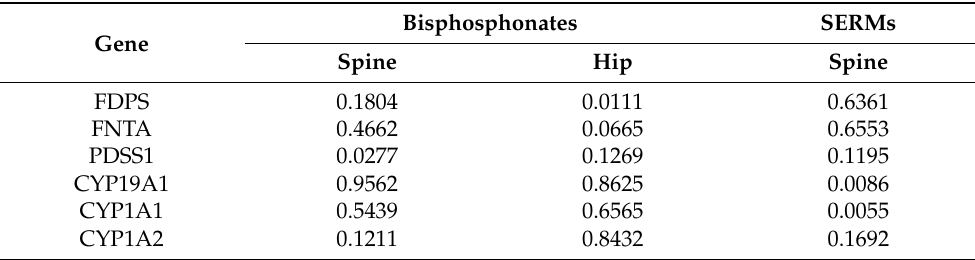
Table 5. Gene-based analysis using MAGMA; p -values of the association of BMD changes with genes are shown in each treatment